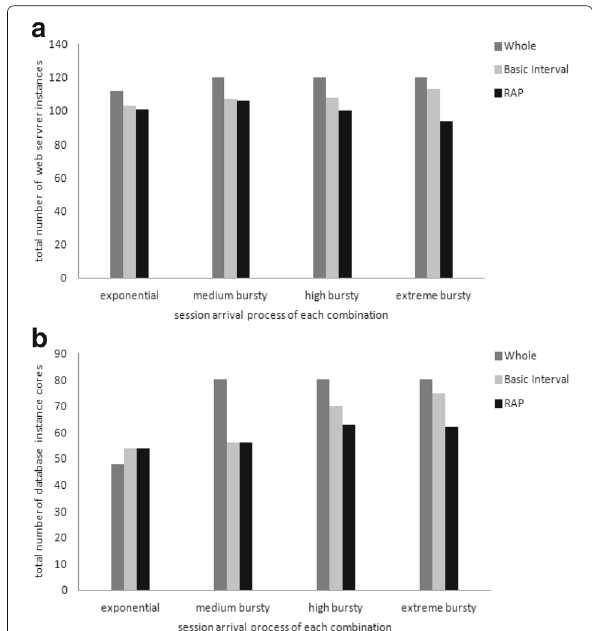
Fig. 9 Impact of degree of burstiness. a Web server instances. b Database instance cores